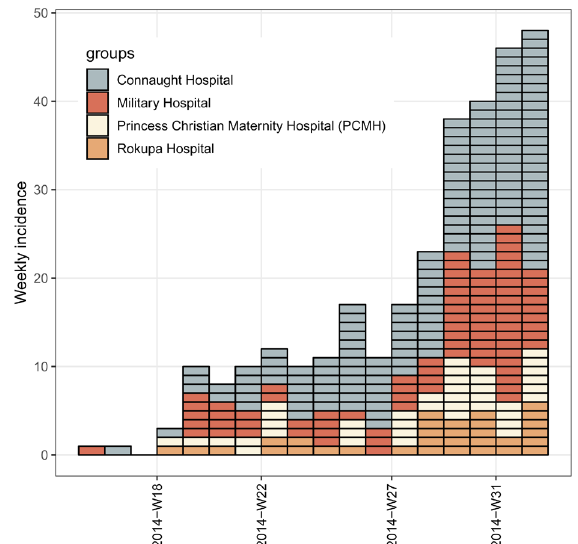
Figure 3. Weekly epicurves stratified by hospitals representing the first eight weeks of simulated outbreak of